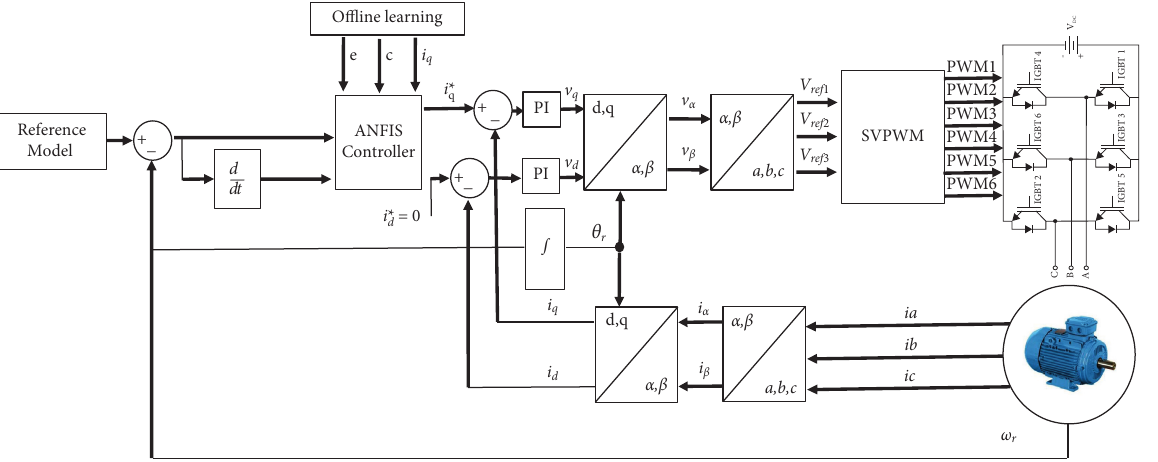
Figure 3: The structure of the used drive. Table 1: Parameters and nominal values of the PMSM. Parameter